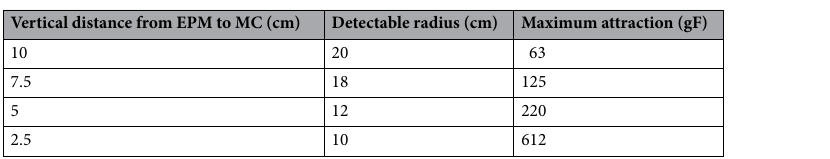
Table 1. Maximum attractive force and effective detectable range in proposed tracking system.